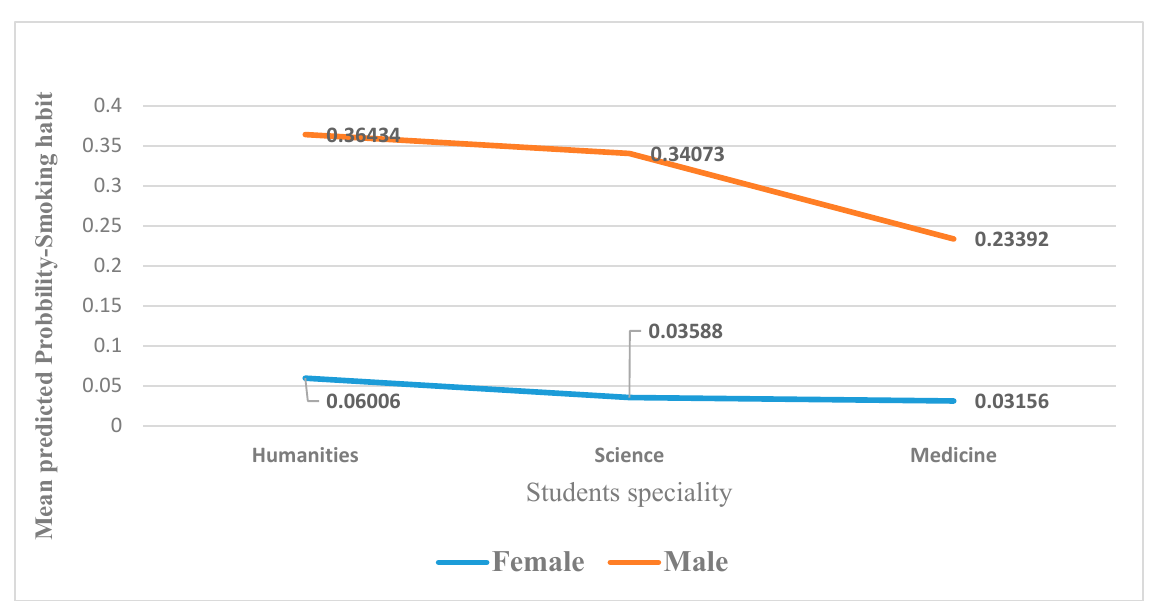
Figure 3. The association between student specialty and sex with their mean predicted probability of a positive history of smoking habits.